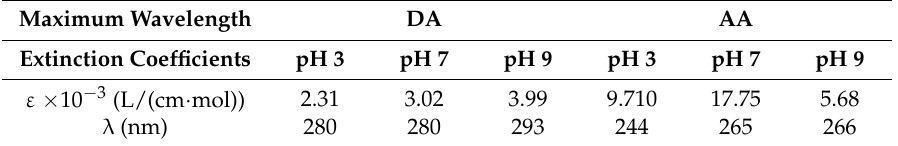
Table 1. Extinction coefficients at pH 3, 7 and 9 at the maximum wavelength of DA and AA. Maximum Wavelength DA AA Extinction